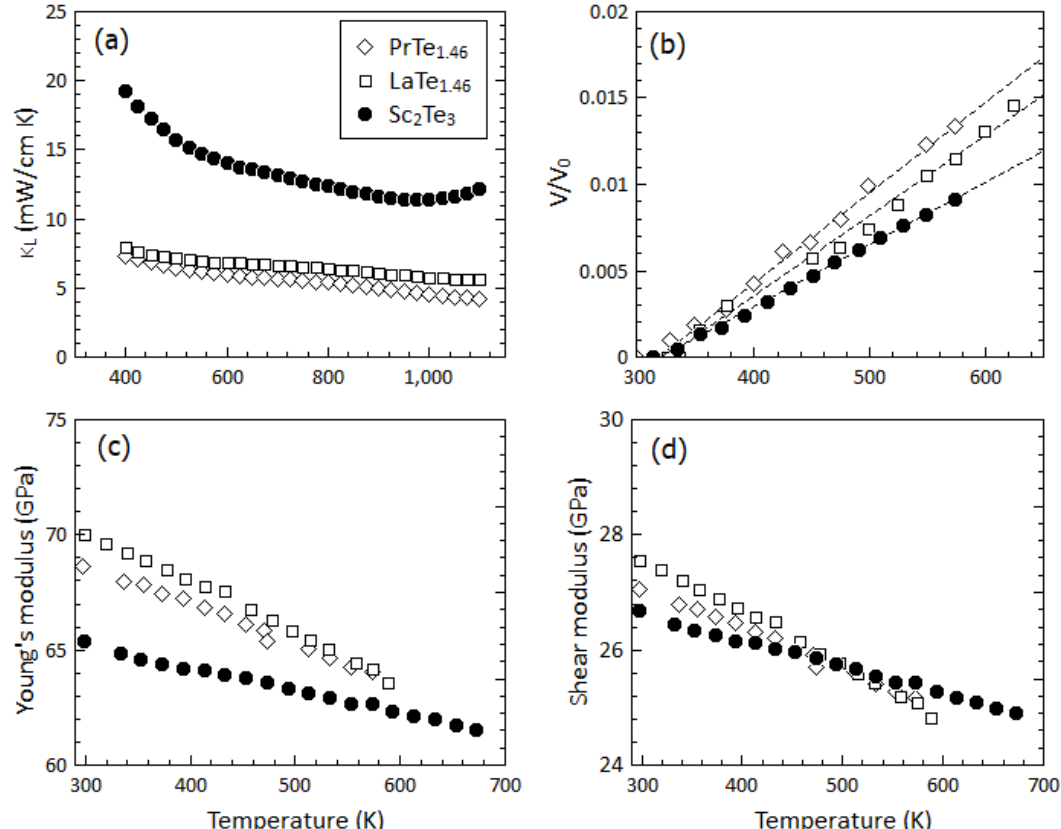
Figure 4. A comparison of ( a ) the lattice thermal conductivity, ( b ) experimental volume thermal expansion, V / V o ( c ) the temperature-dependent Young’s moduli, and ( d ) shear moduli of PrTe 1.46 , LaTe 1.46 , and Sc 2 Te 3 . Data for PrTe 1.33 and LaTe 1.46 are from reference [7]. Table 1. Elastic moduli, speed of sound, density, volumetric coefficient of thermal expansion, and Grüneisen parameters for Sc 2 Te 3 compared with PrTe 1.46 and LaTe 1.46 [7]. Parameters PrTe 1.46 LaTe 1.46 Sc 2 Te 3